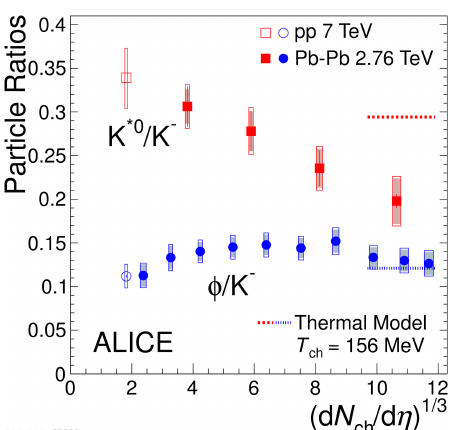
Figure 5. p T -integrated K ∗ 0 /K and φ /K ratios as a function of charge particle multiplicity in different collision systems. Figure taken from [18].